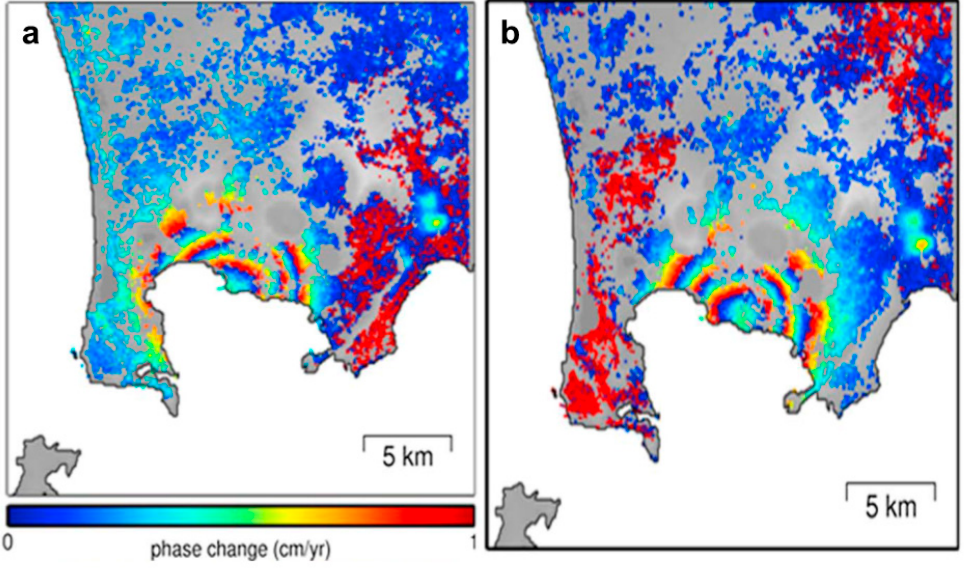
Figure 2. ( a ) LOS deformation velocity computed from ascending passes for the period 1993–2000 and ( b ) LOS deformation velocity computed from descending passes for the period 1992–2000. Modified from